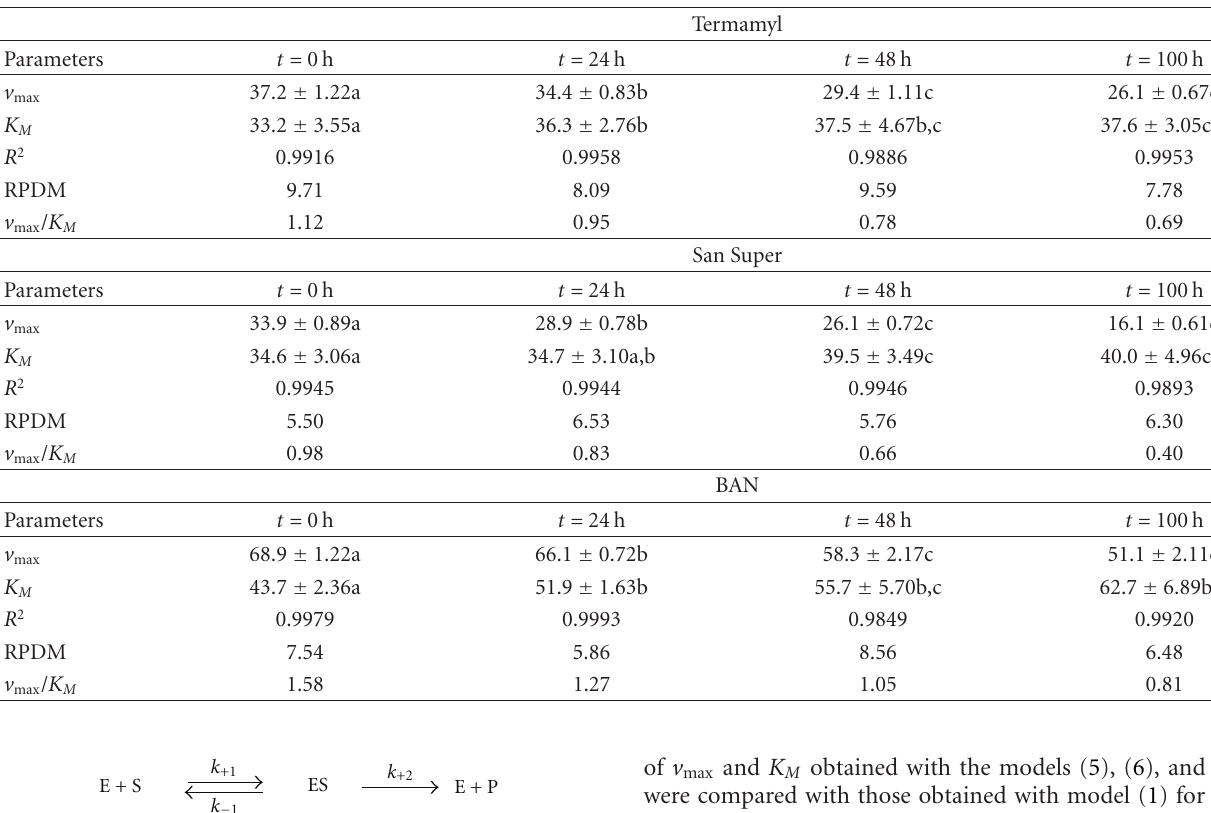
Table 1: Statistically significant ( P < 0 . 05) values (means ± standard errors) of the parameters in the Michaelis-Menten model (1) for the enzymatic reactions of the three amylolytic enzymes on starches aged for di ff erent times (0h, 24 h, 48h, and 100 h). The mean values within rows followed by the same letter are not significantly di ff erent ( P < 0 . 05) from each other.